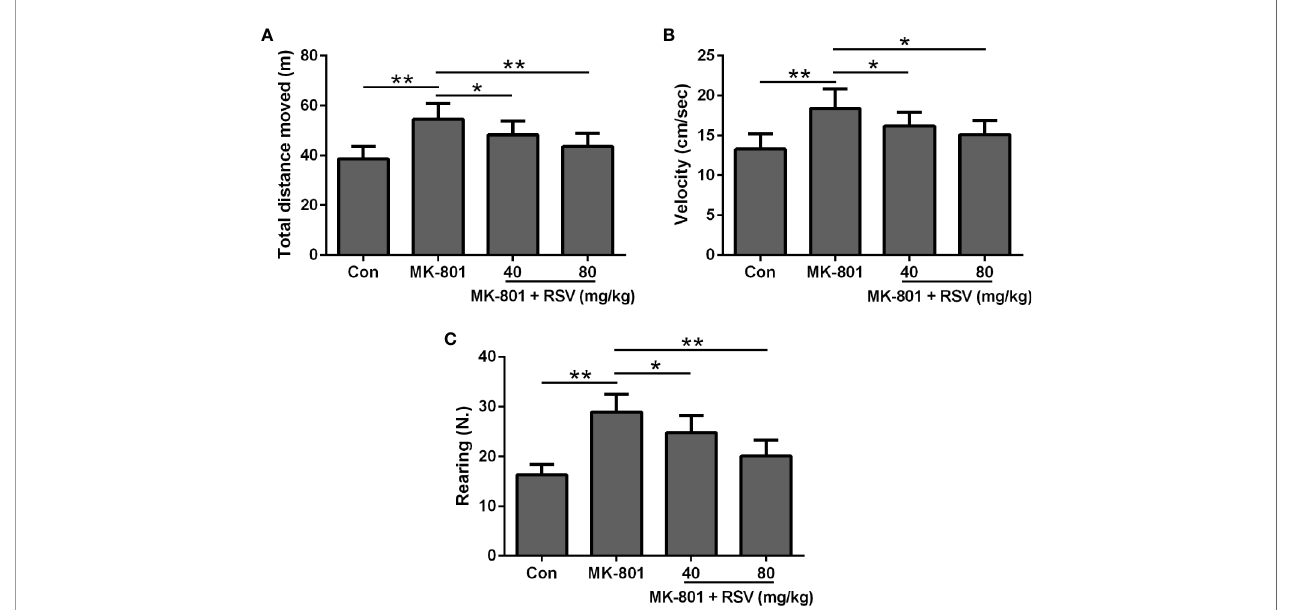
FIGURE 5 | Effect of RSV on the locomotor and exploratory activity of rats exposed to MK-801 in the open fi eld test. Total distance moved (A) , velocity (B) , and rearing number (C) were evaluated. n = 10 in each group. Data were presented as mean ± SD. F ratios: (A) 11.86 (3.00, 20.10), (B) 9.394 (3.00, 18.85), (C) 24.63 (3.00, 21.22). *p < 0.05, **p < 0.01 between the indicated